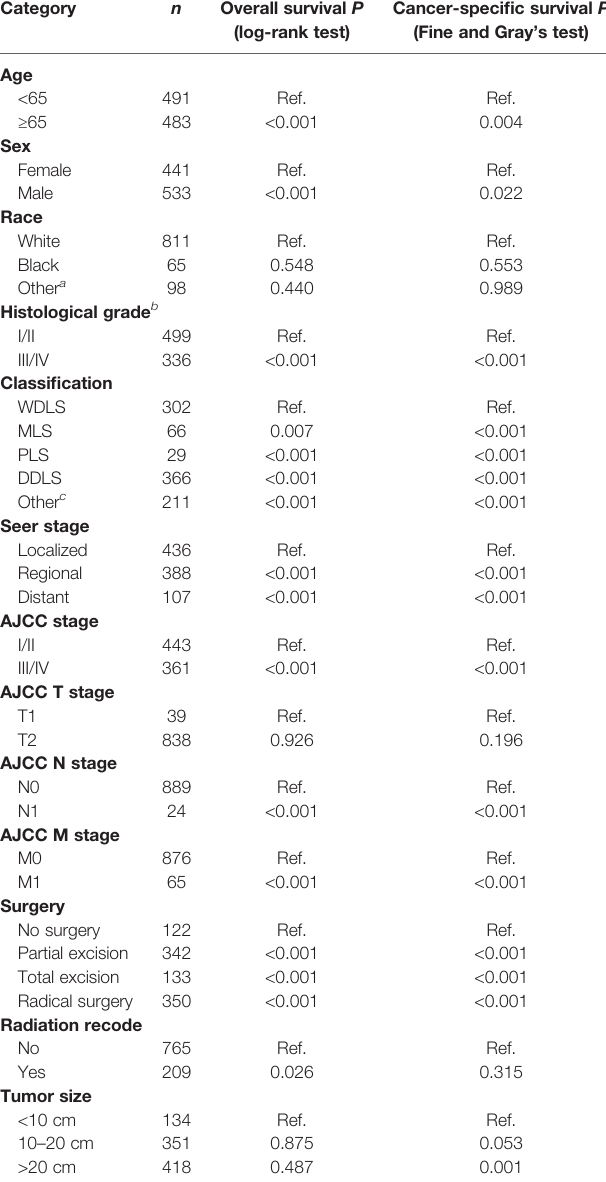
TABLE 2 | Univariate analysis for overall survival and cancer-speci fi c survival in the training